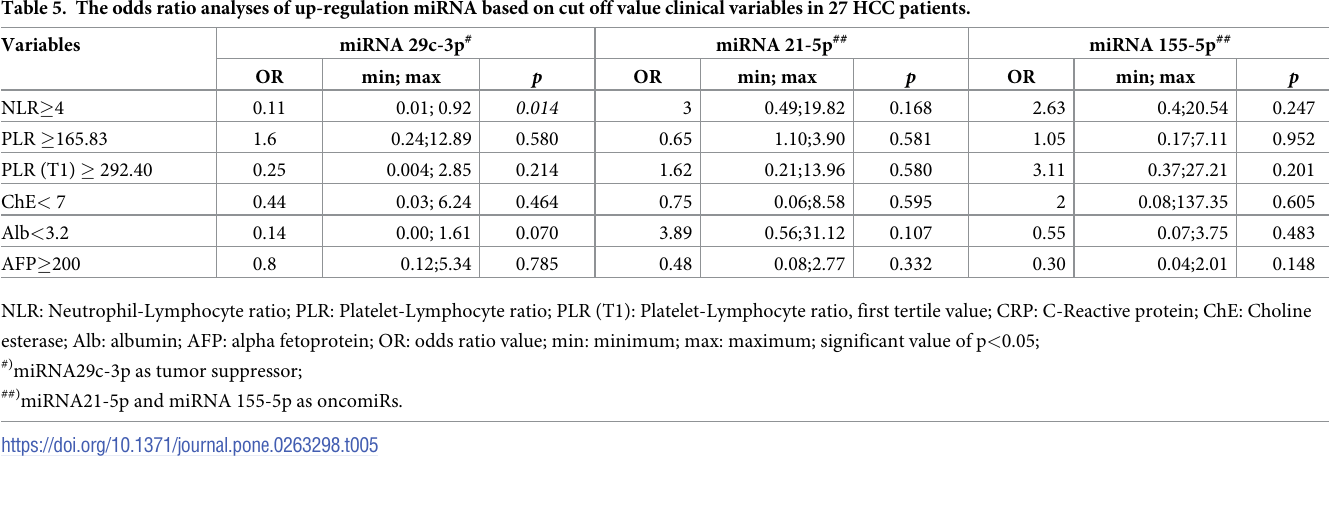
The minimal normal range of ChE ( < 7) used as a cut-off value, ChE may be a preventive factor of miRNA 29c-3p and miRNA 21-5p up-regulation (OR = 0.44; OR = 0.75), even as a predictive factor of miRNA 155-5p up-regulation (OR = 2). Based on cut-off albumin value < 3.2 showed that albumin might be a predictive factor up-regulation of miRNA 21-5p (OR = 3.89), even though as preventive factor up-regulation in miRNA 155-5p (OR = 0.55) and miRNA 29c-3p (OR = 0.14). Based on APASL criteria of AFP � 200 IU/ml, this study results showed AFP might be a